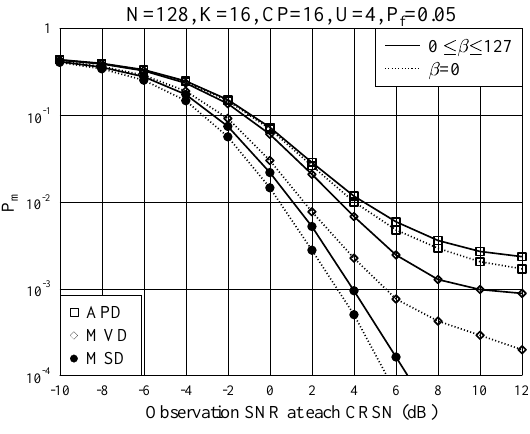
Figure 8. Missing probability of the local CRSNs sensing the spectrum of an IFDMA system using 128 subcarriers to support maximum 16 users, when communicating over multipath Rayleigh fading channels having 5 time-domain resolvable paths. synchronous sensing. By contrast, 0 127 means β ≤ ≤ that β is a random variable taking integer values uniformly in [0 , 127], which provides the average performance achieved by the four synchronisation scenarios considered. From Fig. 8, first, we can see that the MVD outperforms the APD, and that the MSD achieves the best sensing performance among the three local detection schemes. Second, the synchronous sensing results in the best local sensing performance, as there is no inter-carrier interference.